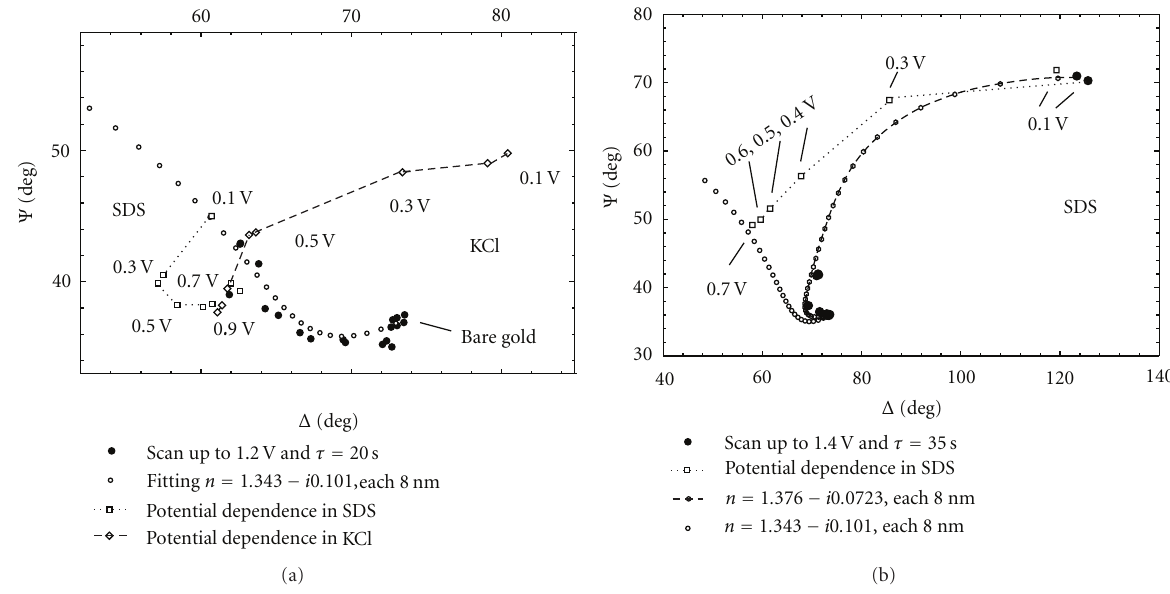
Figure 3: ( • ) Evolution of the experimental parameters Δ and Ψ after successive cycles in the condition of Figure 1, namely, (a) Ea = 1.2V and τ = 20 s, (b) Ea = 1.4 V and τ = 15s. The figures correspond to number of cycles. Evolution of the thicker film changing the potentials in both ( (cid:2) ): SDS and ( ♦ ): after immersion in KCl. ( (cid:5) ): Theoretical values corresponding to a layer of optical index n and increasing the thickness, d , every 8 nm. The film obtained at Ea = 1.2V fits n = 1.343 − i 0.101 and that obtained at Ea = 1.4V fits n = 1.3476 − i 0.0723. Owing of the change in the Δ / Ψ plot scale, both fitted curves are plotted in (b) for comparison.